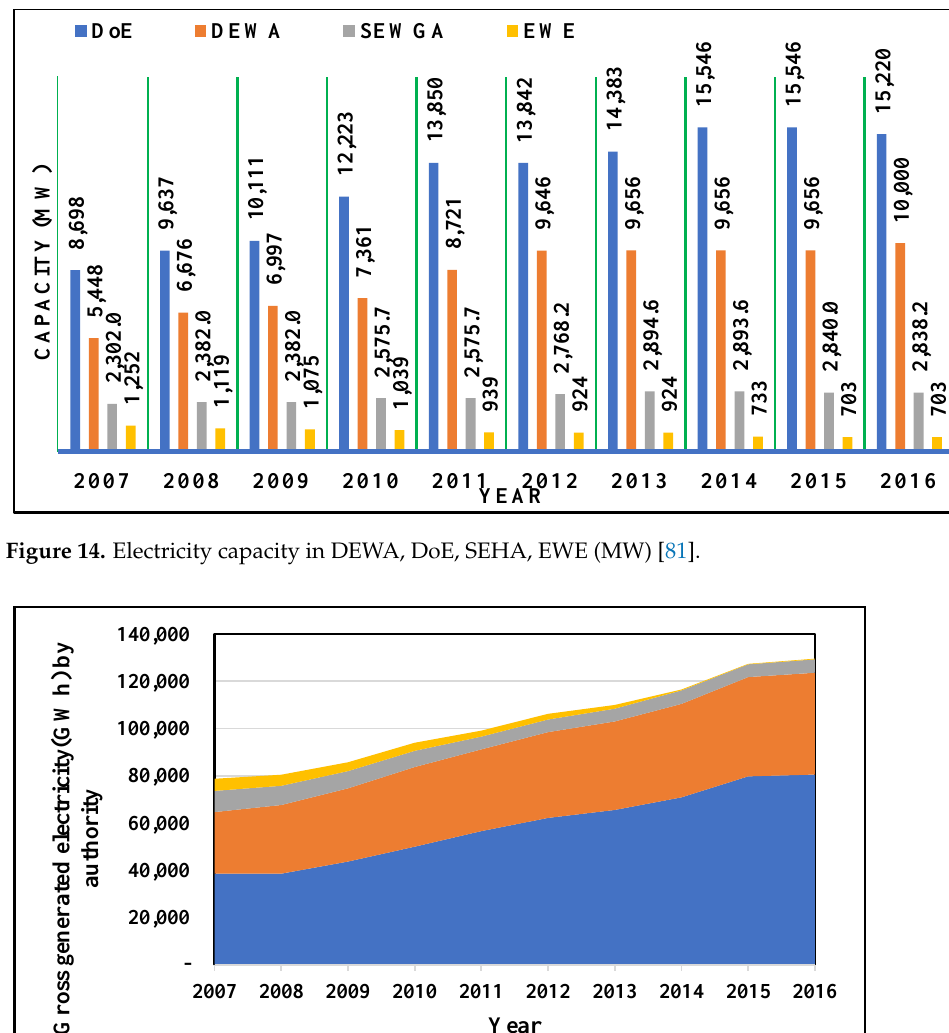
Figure 16. Export and import quantity (GWh) to Oman and Saudi Arabia [81]. Hence, in the recent decade, the UAE ’ s energy power generation and consumption from these authorities have expanded considerably. This electricity has mostly been pro- duced by natural gas-fired power stations in the UAE, which pollute the environment, particularly in terms of CO 2 emissions and other greenhouse gases. This situation is pro- jected to improve in the next few years. To avoid this, governments, businesses, and the general public must acknowledge that the prioritization of climate change problems as a top priority in economic and social growth processes is inescapable. As a result, the UAE government must encourage a diverse energy mix in which electricity may be generated from all traditional energy sources, including sustainable energy, nuclear, and coal power.